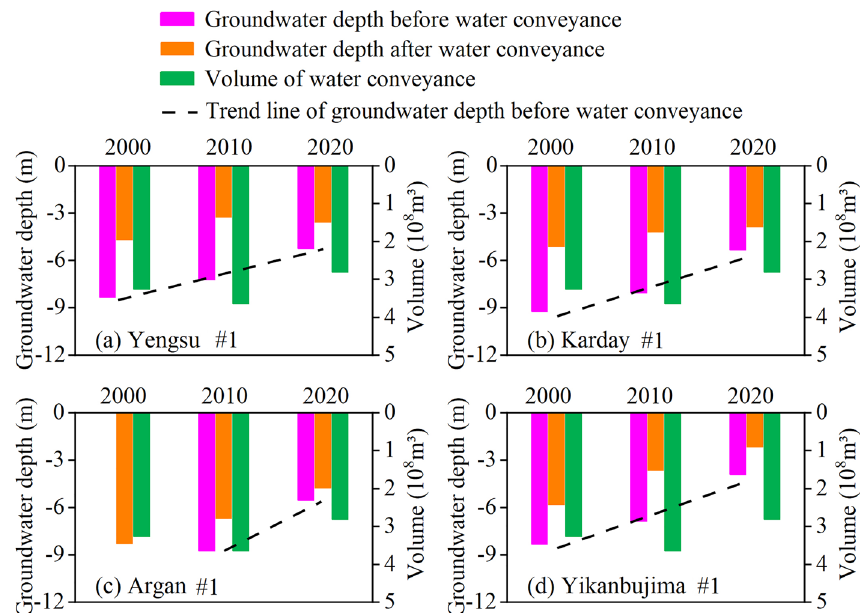
Figure 1. Changes in groundwater depth of typical monitoring cross-sections pre- and post-conveyance of water in the lower reaches of Tarim River from 2000 to 2020. Yengsu, Karday, Argan and Yikanbujima are four monitoring sections in the lower reaches of Tarim River. “#1”is the No. 1 groundwater level monitoring well on each monitoring section, which is located 50 m away from the